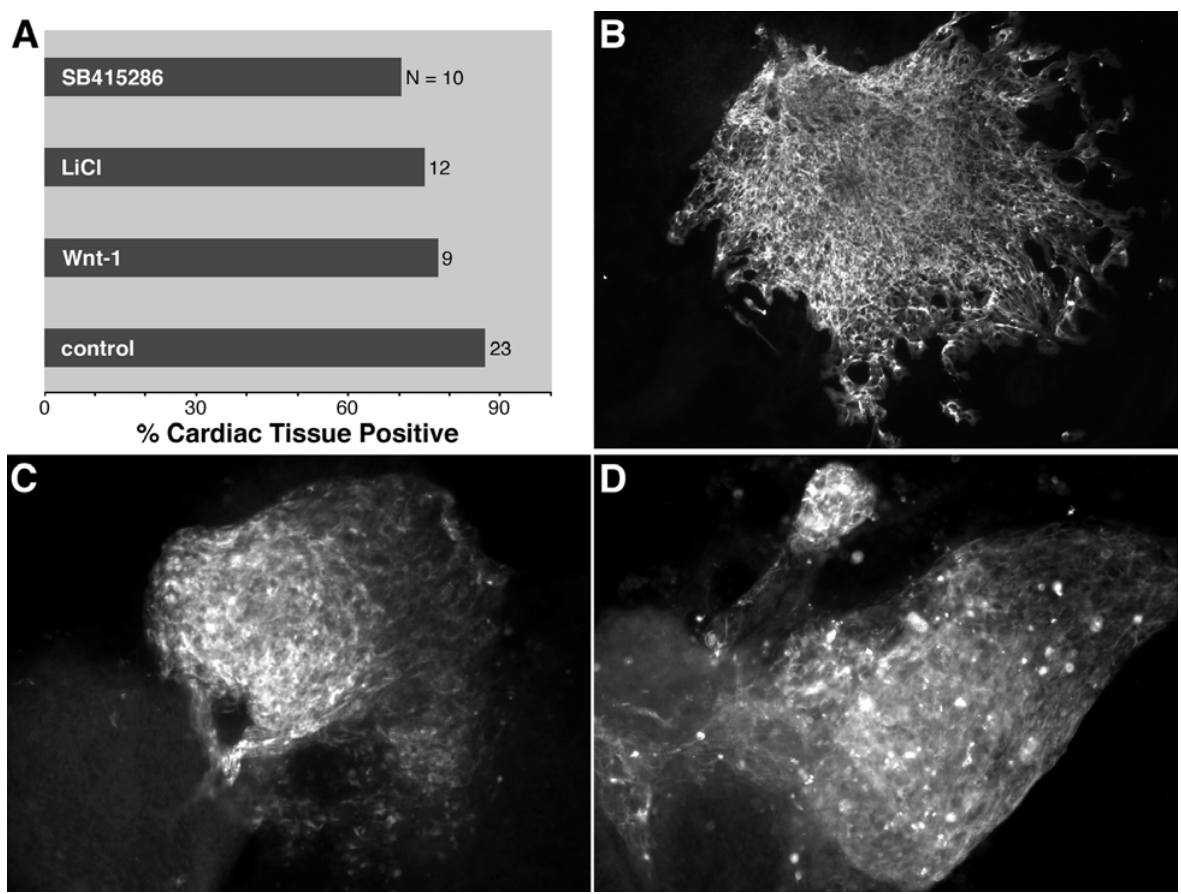
FIGURE 6. Canonical Wnt signaling does not prevent the myocardial differentiation of precardiac mesoderm. Explants of anterior lateral mesendoderm (ALM) were harvested from HH stage 5 chick embryos and cultured in serum-free conditions for 2 days as previously described[86,101], in the presence of control conditioned media, conditioned media from Wnt1-secreting cells, 20 m M LiCl, or the selective GSK3 inhibitor SB415286 (25 µ M ). Cultures were assessed for the formation of contractile tissue and then subsequently immunostained for sarcomeric myosin or titin to confirm the cardiac tissue phenotype of the explants. (A) Scoring of cardiac tissue formation within HH stage 5 ALM explants. The total number of explants examined for each group is listed to the right of each bar. (B–D) Representative explants, treated with Wnt1, LiCl, or SB415286, respectively, and stained for (B) sarcomeric myosin or (C,D) titin after 48 h of culture. The dosages of LiCl or SB415286 used in these experiments were based on functionally optimized concentrations established in multiple published studies[137,138,139]. Wnt1-secreting cells were produced using protocols similar to that described previously for the ectopic expression of Wnt5a and Wnt11[140,141]. Briefly, a full-length mouse Wnt1 cDNA was inserted immediately downstream of the cytomegalovirus promoter in the eukaryotic expression vector pcDNA3 (Invitrogen, Carlsbad, CA), which was transfected into QCE6 cells by means of LipofectAMINE (Invitrogen). Stable transfectant cells were isolated with cloning rings following their selection by their resistance to neomycin. Wnt1-secreting clones were subsequently identified by immunoblotting using a monoclonal antibody specific to Wnt1 protein (Upstate, Charlottesville,